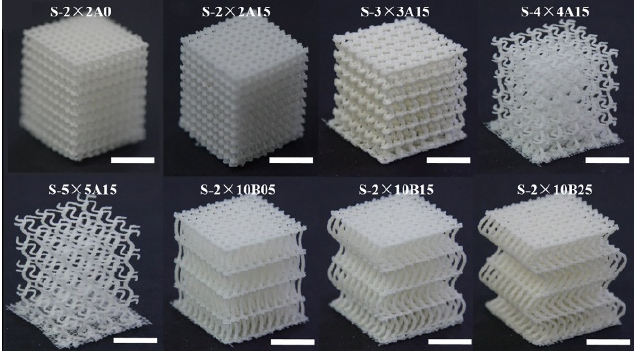
Figure 29. Geometry of SLS-fabricated PCL scaffolds [174] (scale bar: 10 mm).